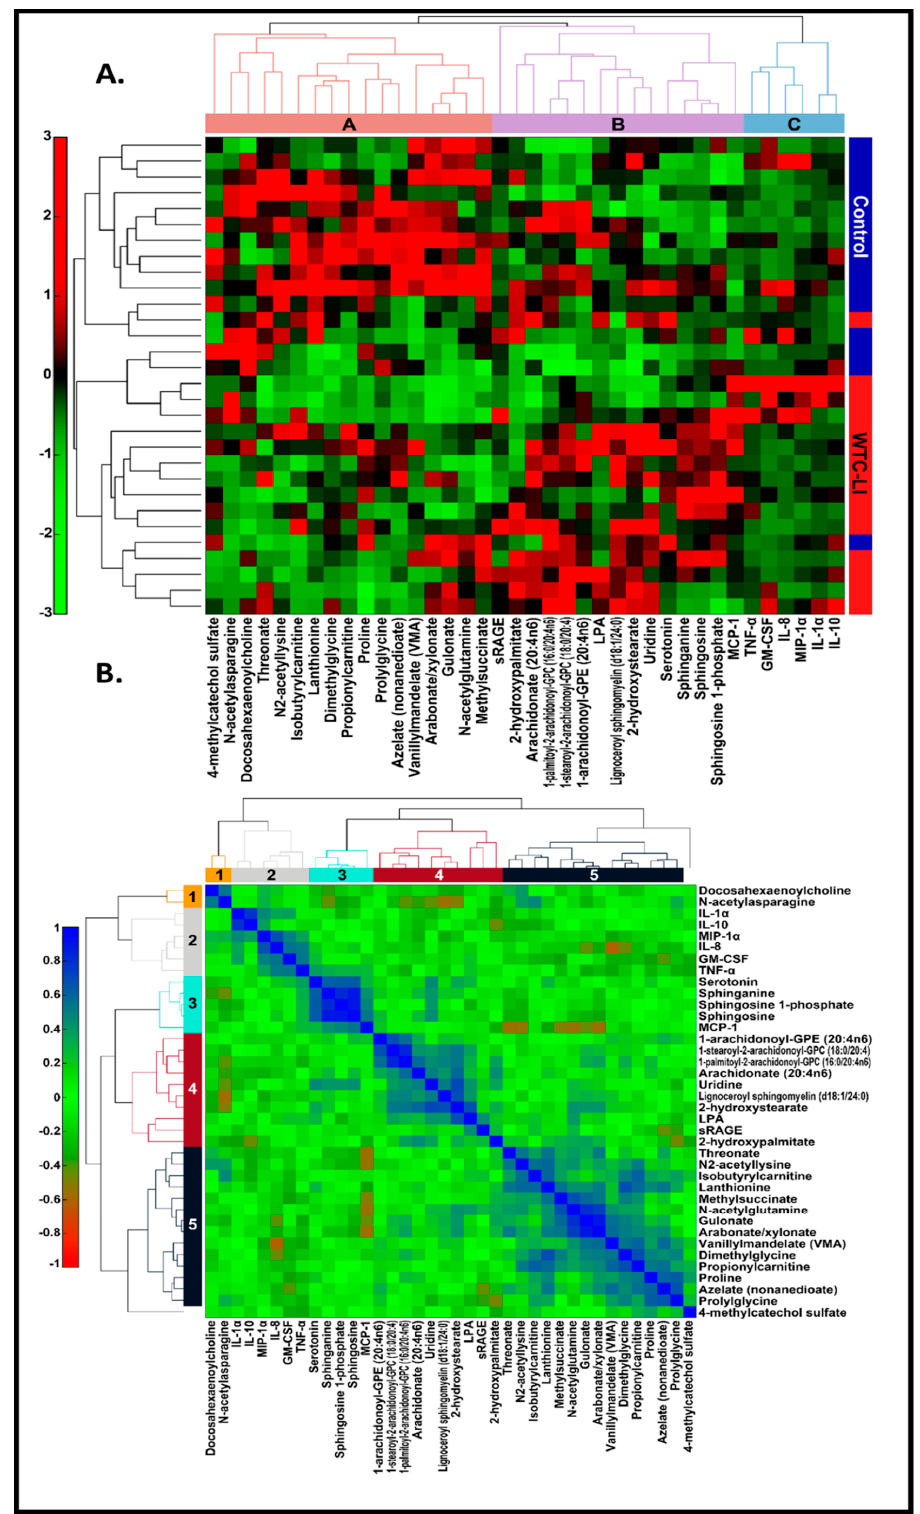
Figure 3. ( A ) Hierarchical clustering of 11 known WTC-LI biomarkers in n = 15 WTC-LI and n = 15 controls, Spearman’s rank correlation, and average linkage [9,15,31,67,68,73,81]. ( B ) Correlation matrix.